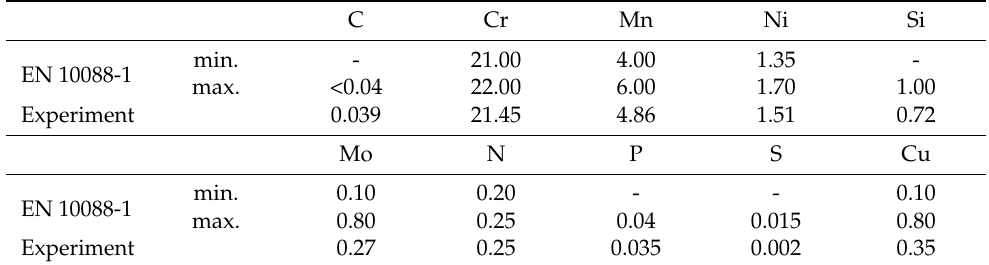
Table 1. Chemical composition (wt.%) of the X2CrMnNiN21-5-1 steel. C Cr Mn Ni Si min. - EN 10088-1 max.